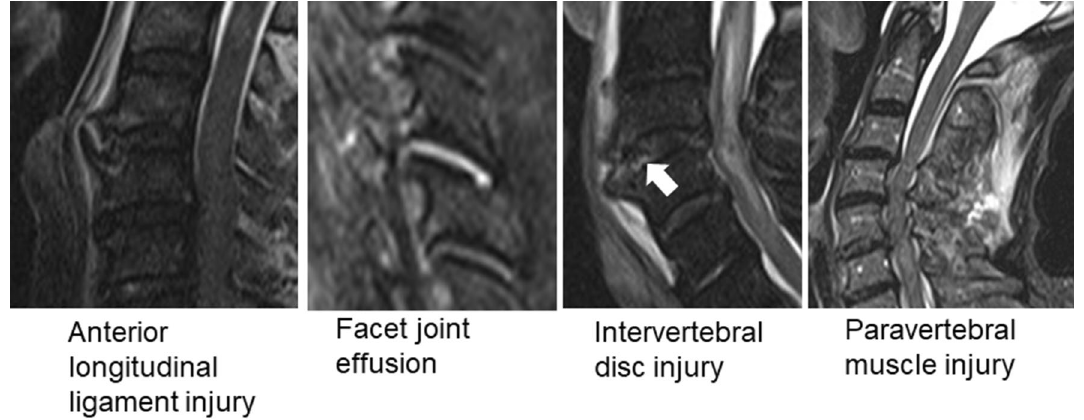
Figure 1. Assessment of cervical spine injury via magnetic resonance imaging (MRI, anterior longitudinal ligament injury, facet joint effusion, intervertebral disc injury (white arrow), and paravertebral muscle injury were assessed on T2-weighted MRI images of the cervical spine or short tau inversion recovery